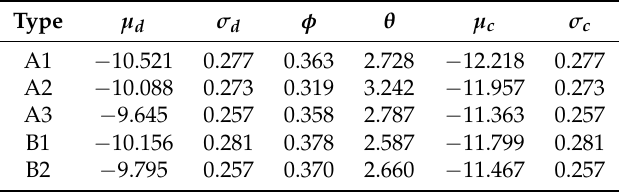
Table 1. Related parameters of porous